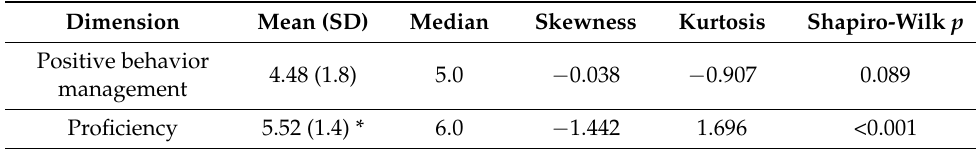
Table 6. Descriptive statistics and normality assessment for the ratings of quality of referee–player interactions in positive behavior management and proficiency of rugby referees ( n =